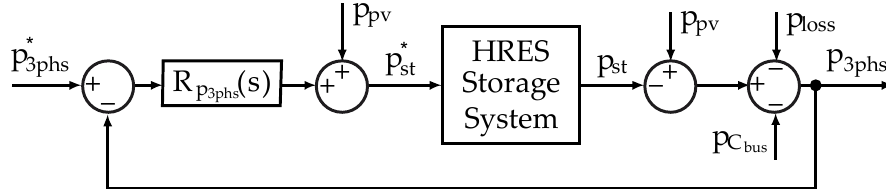
Figure 3. Closed-loop scheme to control the active power exchanged with the three-phase section of the HRES.